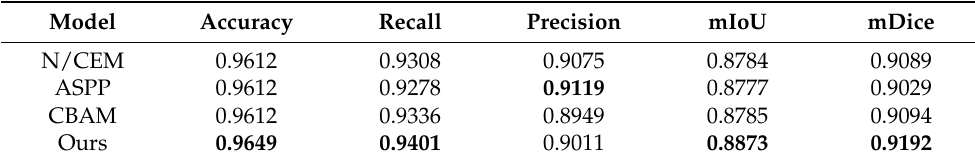
Table 4. Comparison of experimental results with or without CEM.